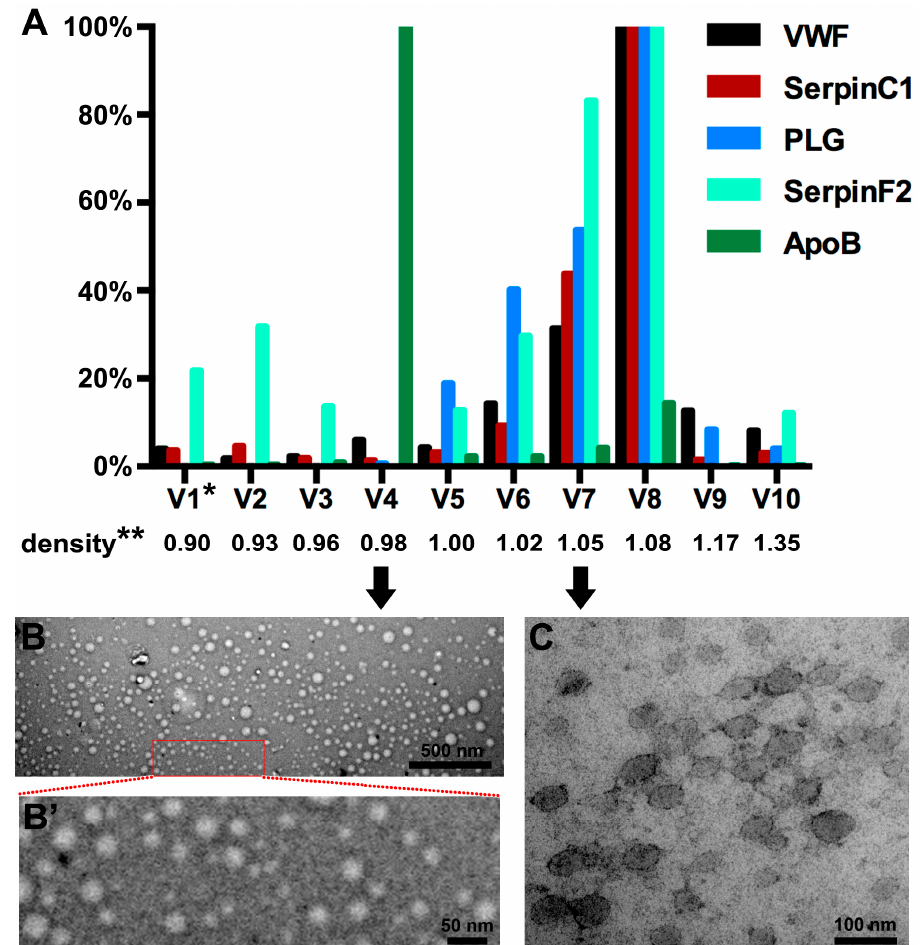
Figure 3. Distribution of VWF, SerpinC1, PLG, SerpinF2, and ApoB in density sub-fractions of the (V)LDL precipitate after density gradient centrifugation. * V1, the first sub-fraction of (V)LDL precipitate. The density of each sub-fraction was indicated accordingly. ** The unit of density is g/mL. ( A ) Protein levels of VWF, SerpinC1, PLG, and SerpinF2 are presented as the percentage of the 8th sub-fraction (V8). Protein levels of ApoB are presented as the percentage of the 4th sub-fraction (V4). ( B ) A representative electron microscope (EM) image of the 4th sub-fraction shows lipoprotein particles. Scale bar = 500 nm. ( B’ ) Larger magnification of insert in ( B ). Scale bar = 50 nm. ( C ) A representative EM image of the 7th sub-fraction shows EVs. Scale bar = 100 nm.